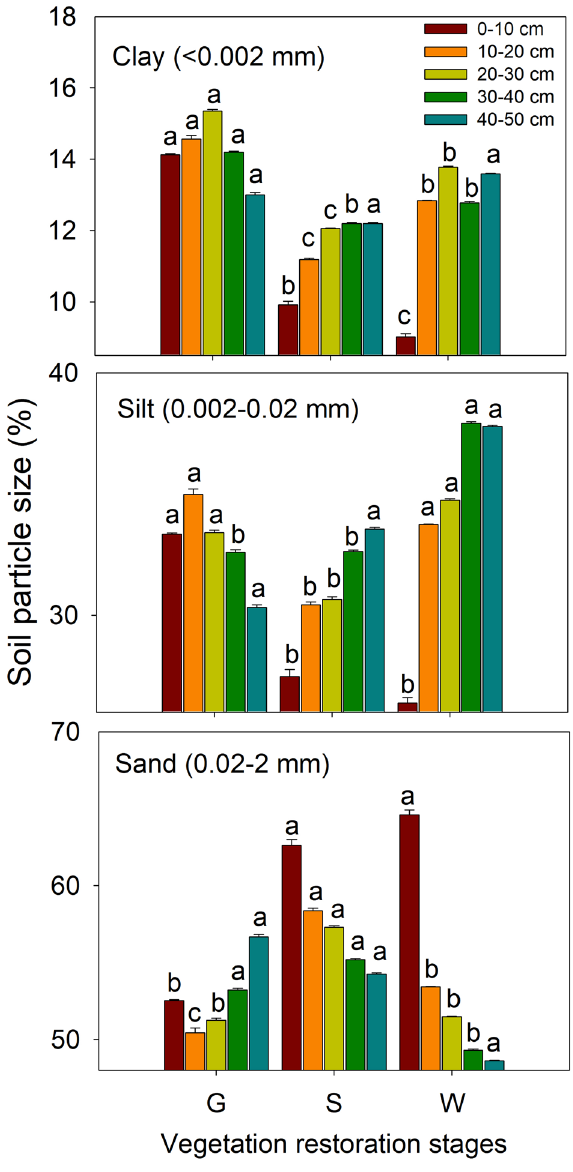
Figure 7. The contents of clay (< 0.002 mm), silt (0.002–0.02 mm) and sand (0.02–2 mm) in the different soil layers at different vegetation restoration stages (see Table 1). The values are in the form of means ± SEs, and the sample size (n) is 5. The different lowercase letters above the bars indicate significant differences within a soil layer among the different vegetation restoration stages ( P <